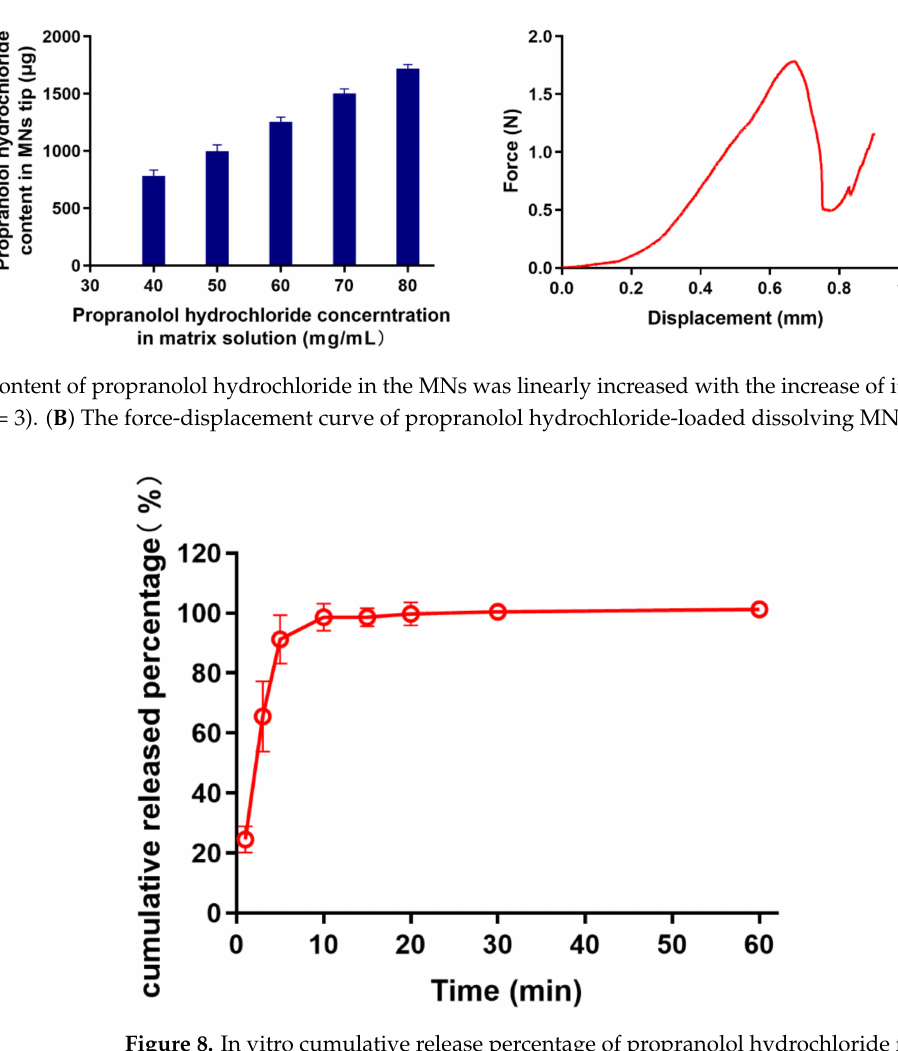
Figure 8. In vitro cumulative release percentage of propranolol hydrochloride from dissolving MNs ( n =